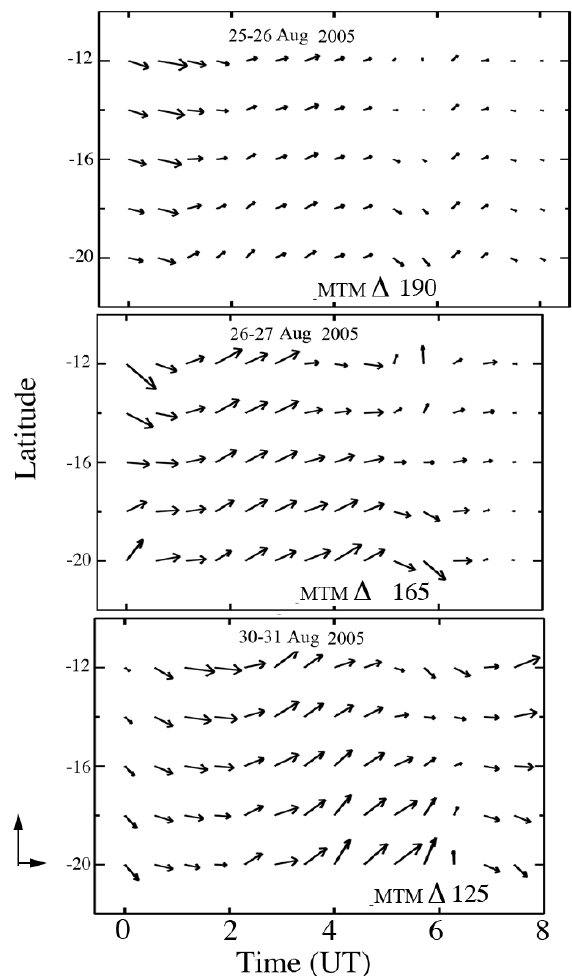
Fig. 7. Horizontal wind maps for three nights in August, 2005. Neu- tral wind vectors are computed for 2 ◦ intervals of latitude between − 12 ◦ and − 20 ◦ and every 30min in UT. Local midnight occurs at 05:00UT. The time of the MTM peak amplitude is indicated by the open triangle next to the MTM label and the amplitude of the MTM peak is indicated. An horizonal meridional or zonal wind speed of 100ms − 1 is represented by the scale distance of 2 ◦ latitude or 30min, respectively (see insert, lower left